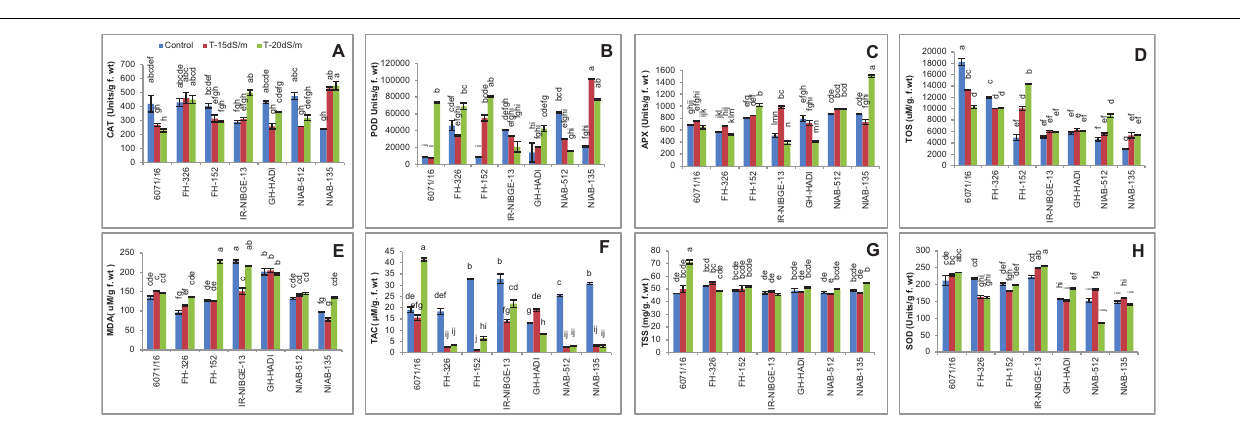
FIGURE 12 | Comparison of panels (A) catalase, (B) peroxidase, (C) ascorbate peroxidase, (D) total oxidant status, (E) malondialdehyde, (F) total antioxidant capacity, (G) total soluble sugar, and (H) superoxide dismutase in cotton genotypes under stress and non-stress